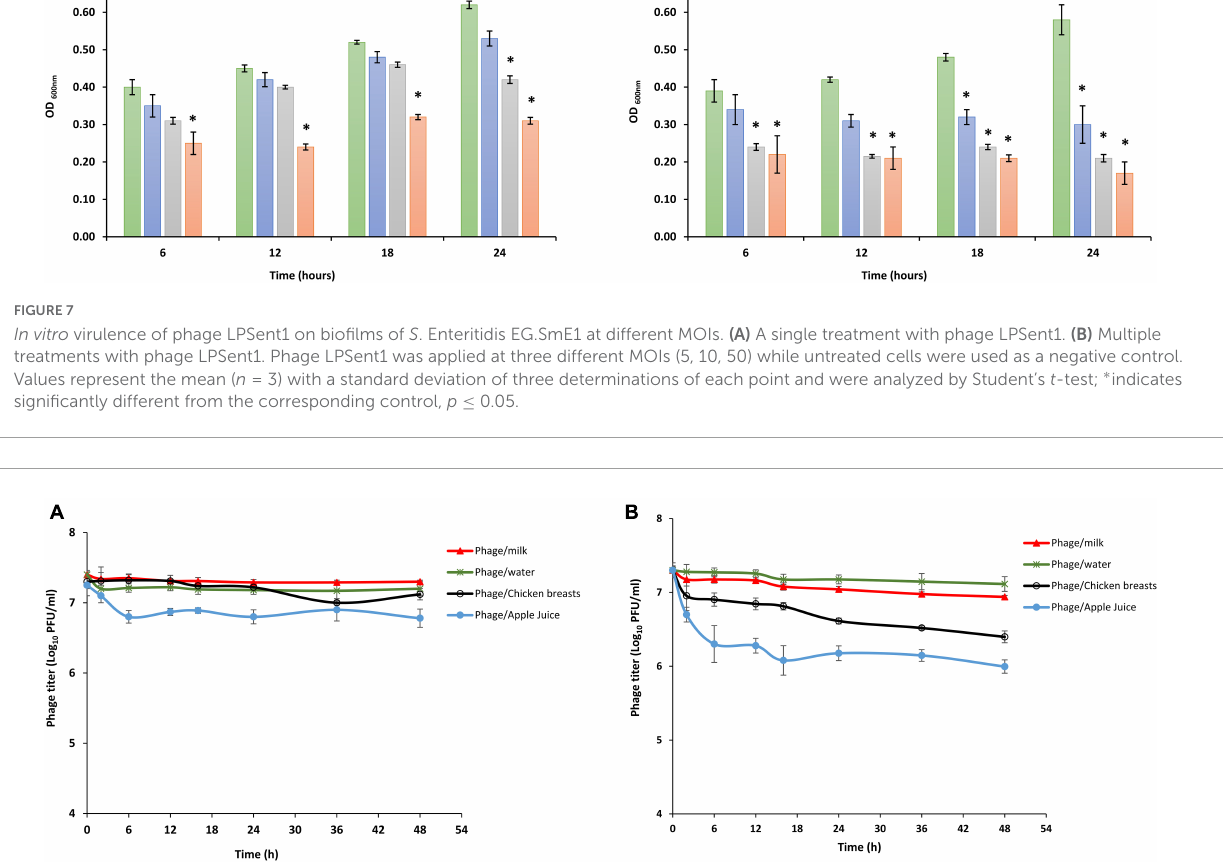
FIGURE8 Analysis of LPSent1 stability in four food matrices (milk, water, apple juice and chicken breast). Phage-treated food samples were incubated for 48 h at either 4 ◦ C (A) or at 25 ◦ C (B) , and aliquots were taken at 0, 2, 6, 12, 16, 24, 36, and 48 h, and residual phage titers were measured as PFU/mL. Values represent the mean with a standard deviation of three determinations of each